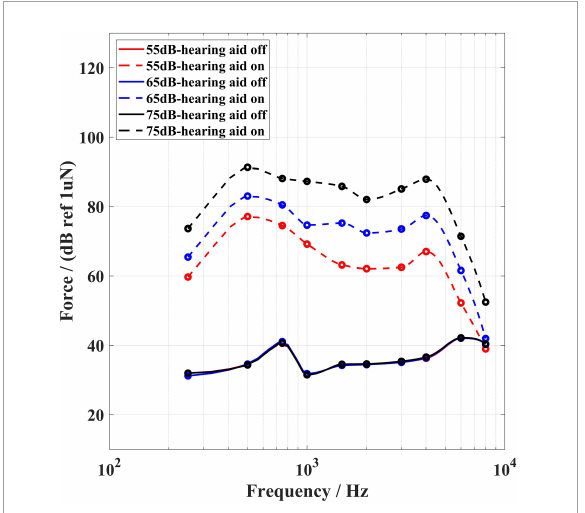
the loudspeaker turned on and the BC hearing aid turned off, while the dashed lines indicate the force level is measured by the force transducer with the loudspeaker turned on and the BC transducer of the hearing aid playing the aided signal. The red, blue, and black lines indicate the stimulation inputs with an overall SPL of 55, 65, and 75 dB, respectively. The three solid lines were